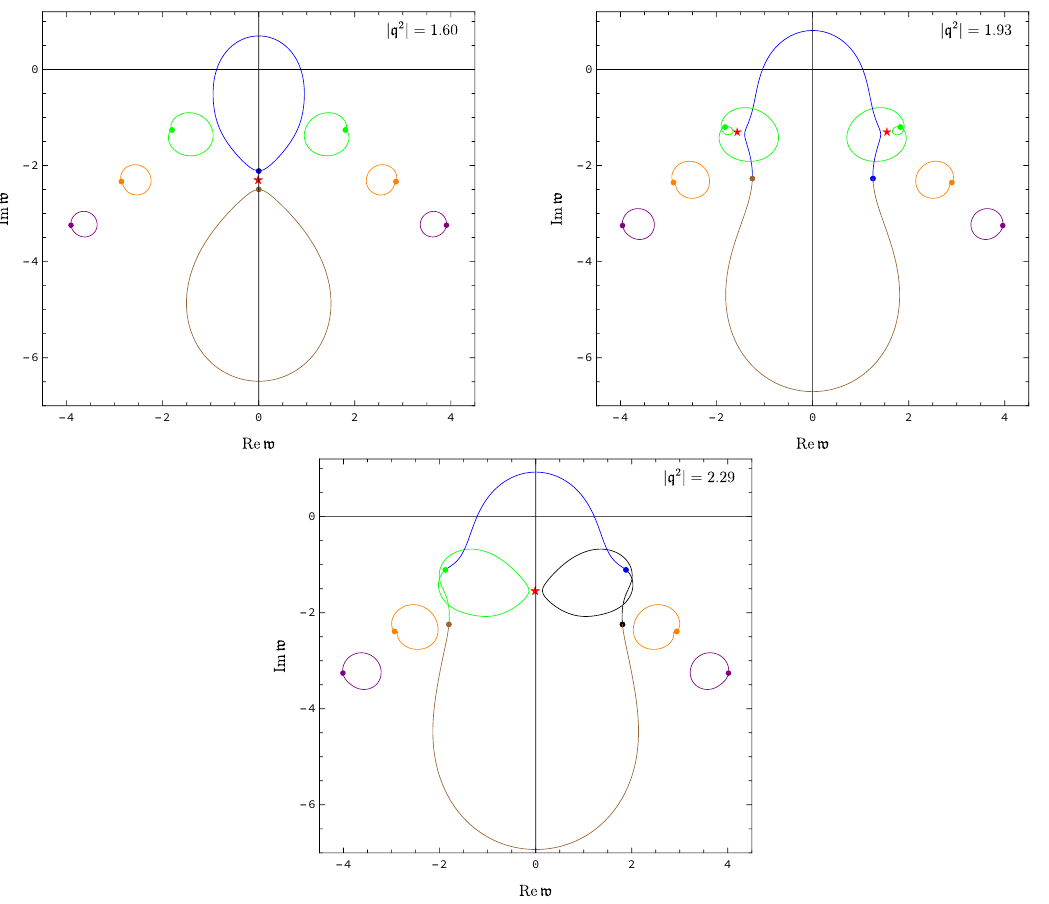
Figure 12 . Quasinormal spectrum in the shear channel of Gauss-Bonnet theory, computed non- perturbatively in λ , at λ = − 0 . 03 GB GB